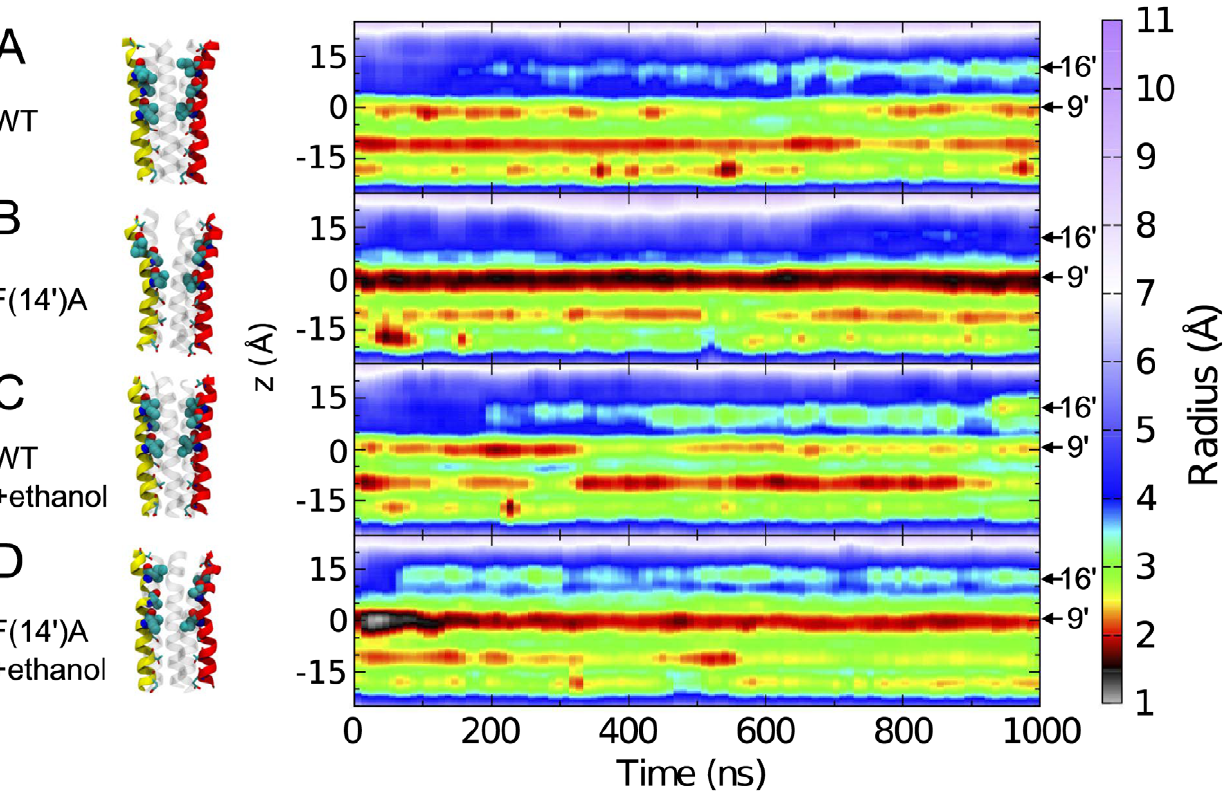
Figure 2. Pore constrictions. Pore radius as a function of membrane z-axis plane (left axis) and time (lower axis) for the ( A ) WT, ( B ) F(14 9 )A, ( C ) WT + ethanol and ( D ) F(14 9 )A + ethanol simulations. Prominent constriction points were observed around 10 A˚/I(16 9 ), 0 A˚/I(9 9 ), 2 10 A˚/T(2 9 ), and 2 18 A˚/E( 2 2 9 ). Structures on the left show the pore helices at the end of the 1- m s simulation with two M2 helices colored red and yellow and the three others as transparent cartoons. Residues lining the pore are shown as spheres for hydrophobic residues I(16 9 ) and I(9 9 ) and as sticks for polar residues T(20 9 ), S(6 9 ), T(2 9 ) and E( 2 2 9 ).